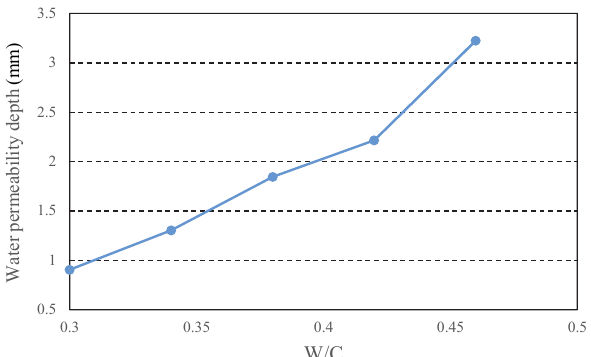
Figure 5: Water permeability depth in terms of different values of water-cement